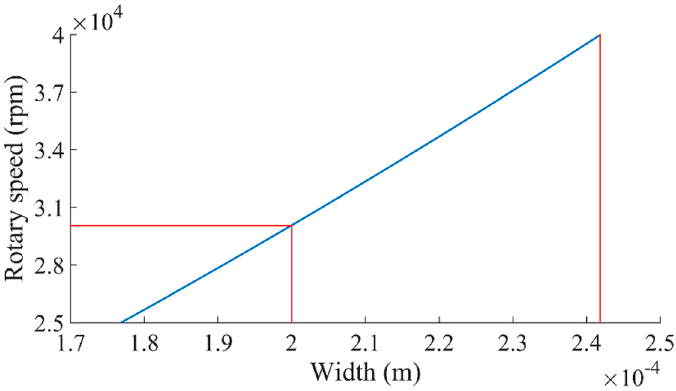
Figure 3. The theoretical calculation results of the centrifugal insurance mechanism.